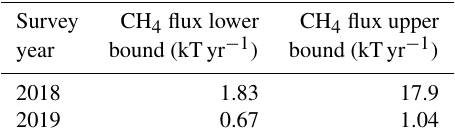
Table 1. A comparison of flux lower and upper bounds for two indi- vidual example plumes across each year of survey as scaled by the vertical resolution available. The plumes themselves are not compa- rable, but the method changes demonstrate the increased certainty in the final